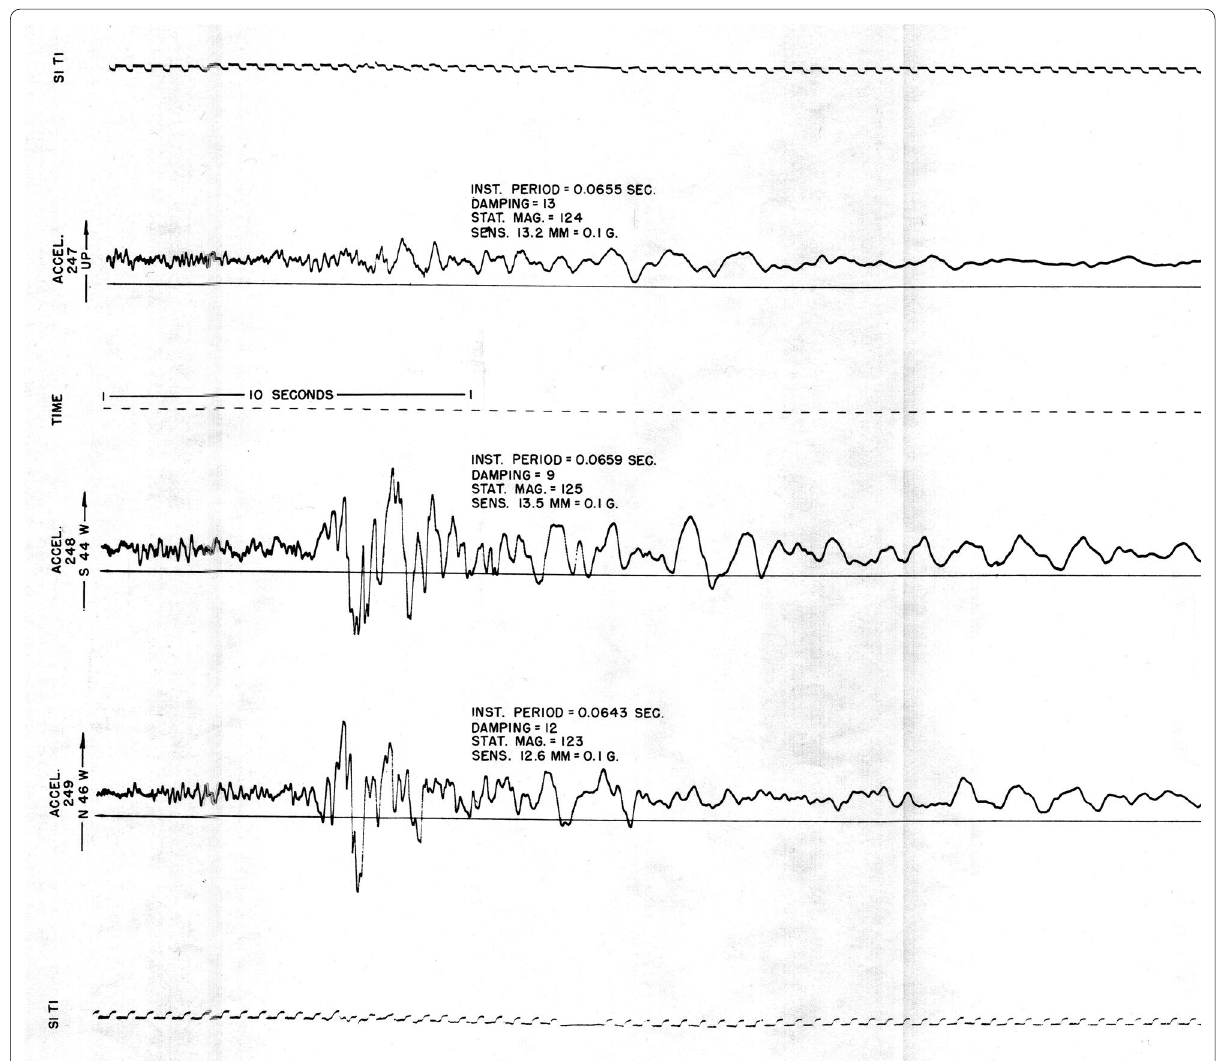
Fig. 8 An example of a Develocorder-type recording. Three-component strong-motion recordings of the Ferndale, CA earthquake, on December 21, 1954. There are three time channels, at the top, bottom, and between top and middle traces. The middle time channel indicates that a pair of line and gap covers 0.5